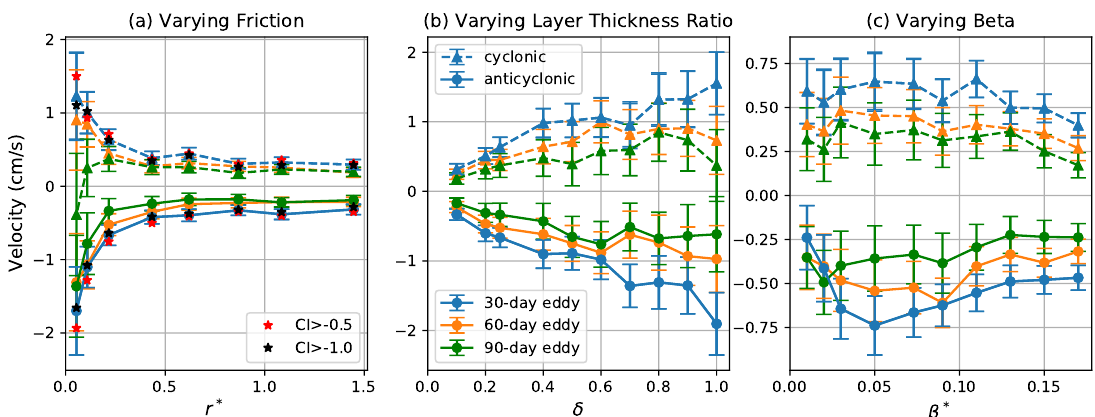
Figure 10. Meridional propagation velocity of coherent eddies as a function of ( a ) r ∗ , ( b ) δ , and ( c ) β ∗ . Blue, orange, and green curves with correspond to the mean of the meridional propagation velocity for 30-, 60-, and 90-day eddies, respectively, and dashed curves with triangles and solid curves with circles indicate cyclonic and anticyclonic eddies, respectively. Error bars give two times the standard error of the mean. Red and black stars in the left panel indicate the mean for 30-day eddies detected by varying the CI threshold to − 0.5 and − 1.0,